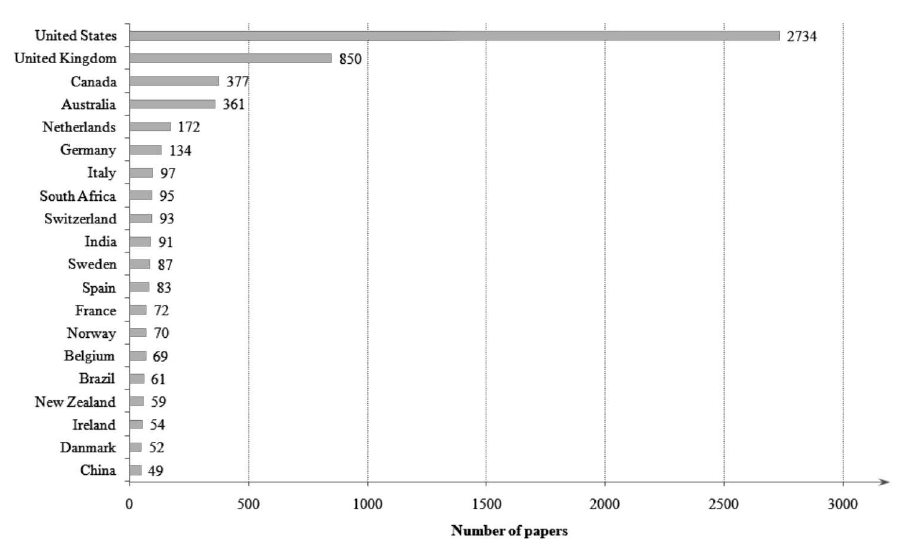
Figure 5. Number of publications on the quality management of